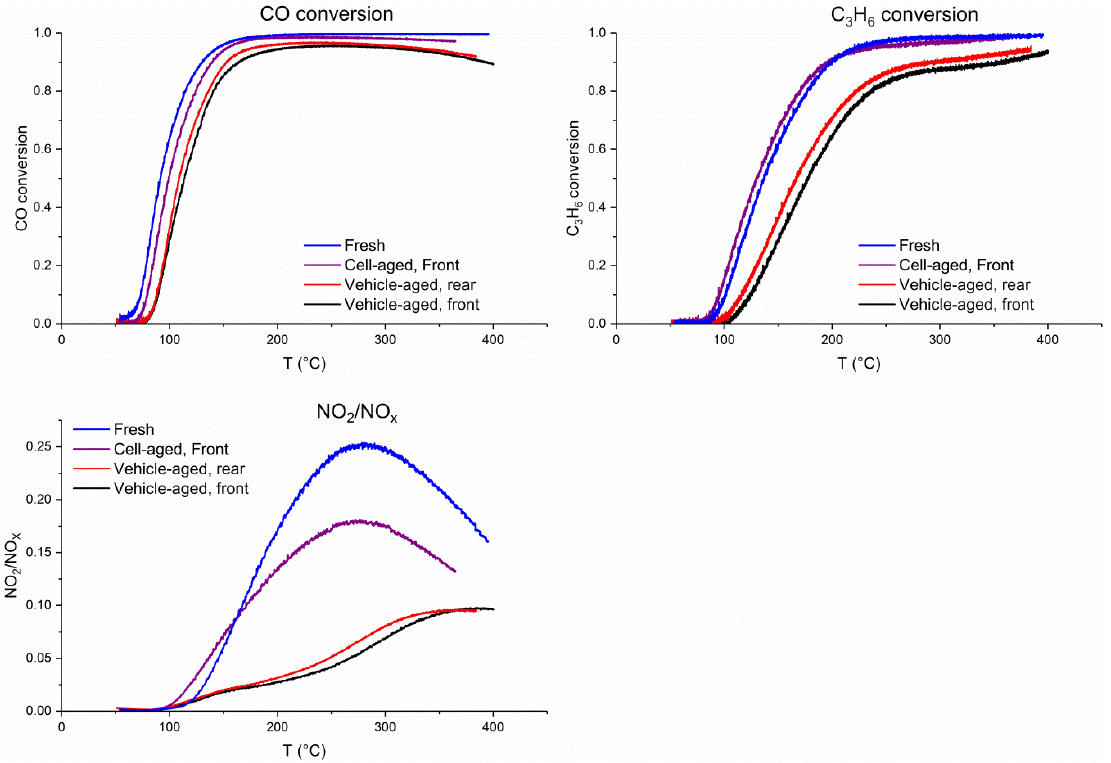
Figure 5. Schematic showing the effect of the contaminant removal procedures on the presence of different trace elements in the DOC.